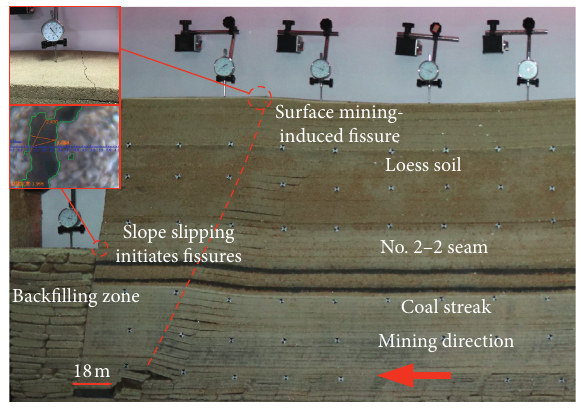
Figure 5: The “slope-pillar” nonuniformly loaded structure.